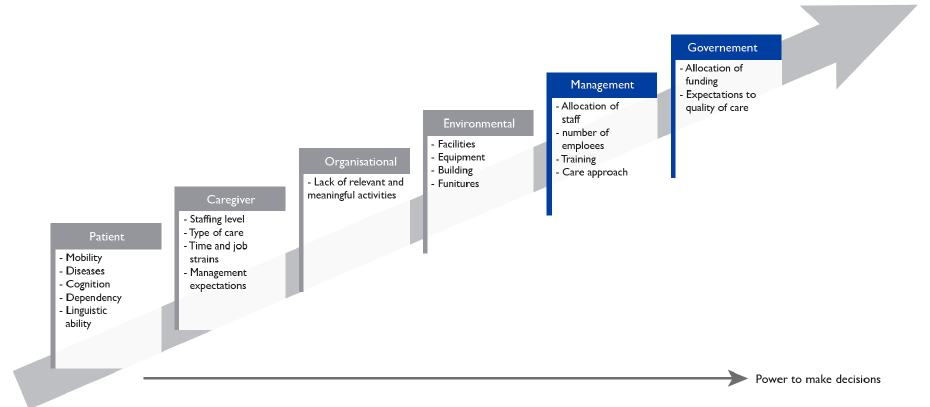
Figure 1. Factors influencing residents’ physical and social inactivity in residential care extending the work from Douma et al. [46] and den Ouden et al. [9].